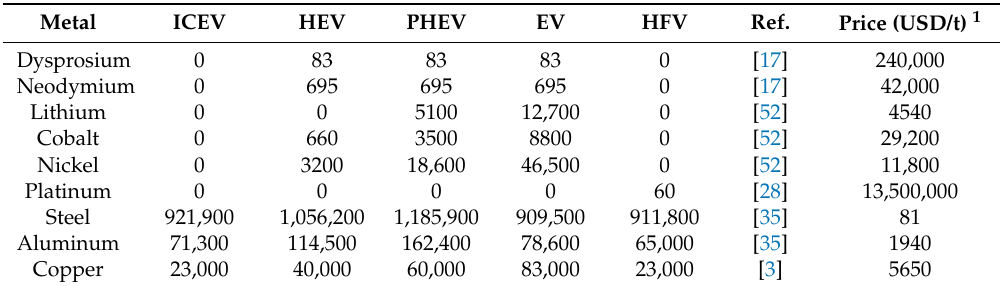
Table 6. Metal intensity in next-generation vehicles (Unit: